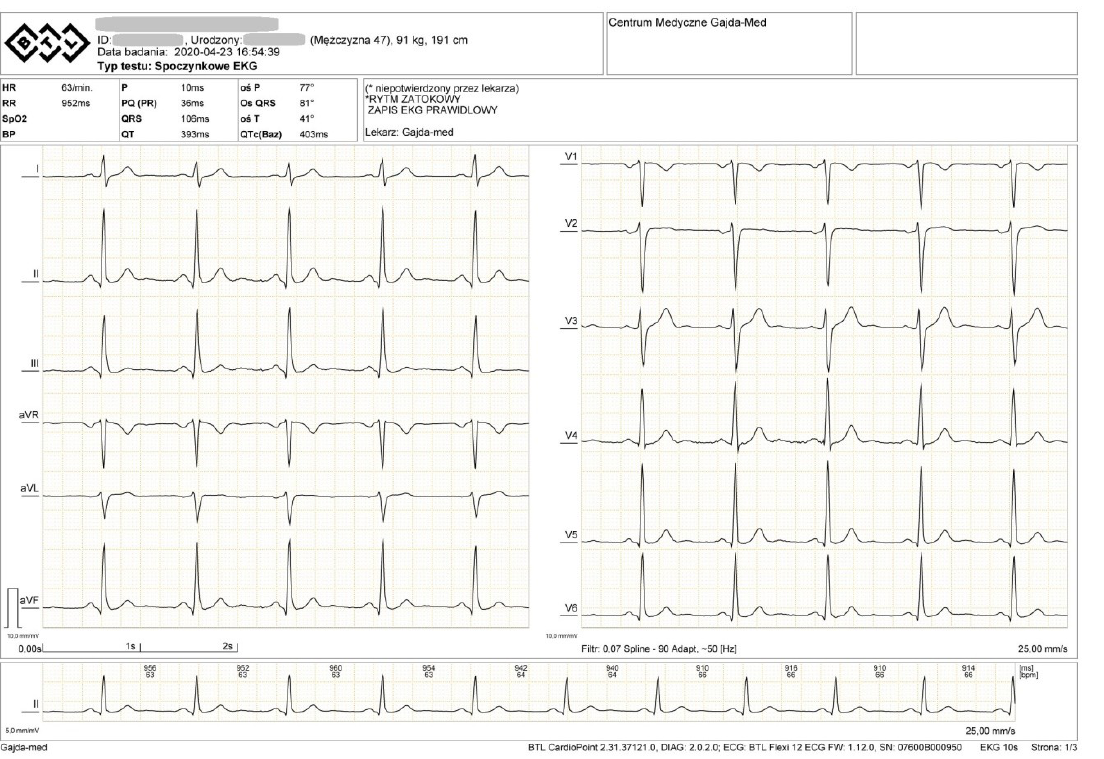
Figure 3. ECG of the examined